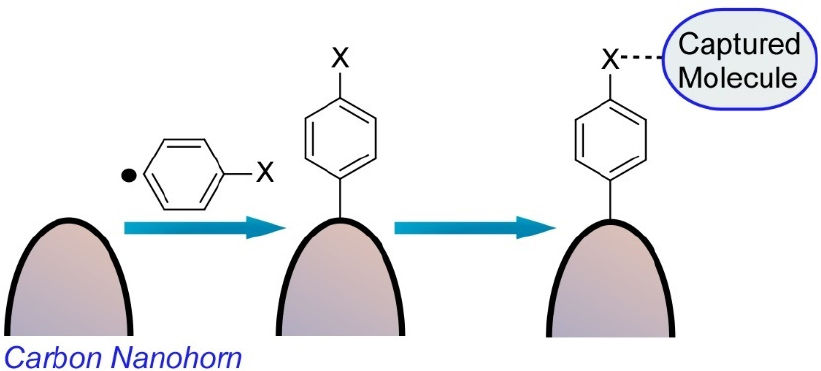
Figure 3. Molecular attachment to a surface of a carbon nanohorn for a single molecular level observation. Fundamentals of coordination processes can be investigated with this technique. Atomic-level structure analyses on prenucleation clusters in syntheses of metal-organic frameworks (MOFs) were carried out using the SMART-EM technique by Harano and co-workers (Figure 4) [71]. As representative examples, two MOF structures (MOF-2 and MOF-5) can be obtained from the same precursors—zinc nitrate and benzene dicarboxylic acid—in dimethylformamide under different